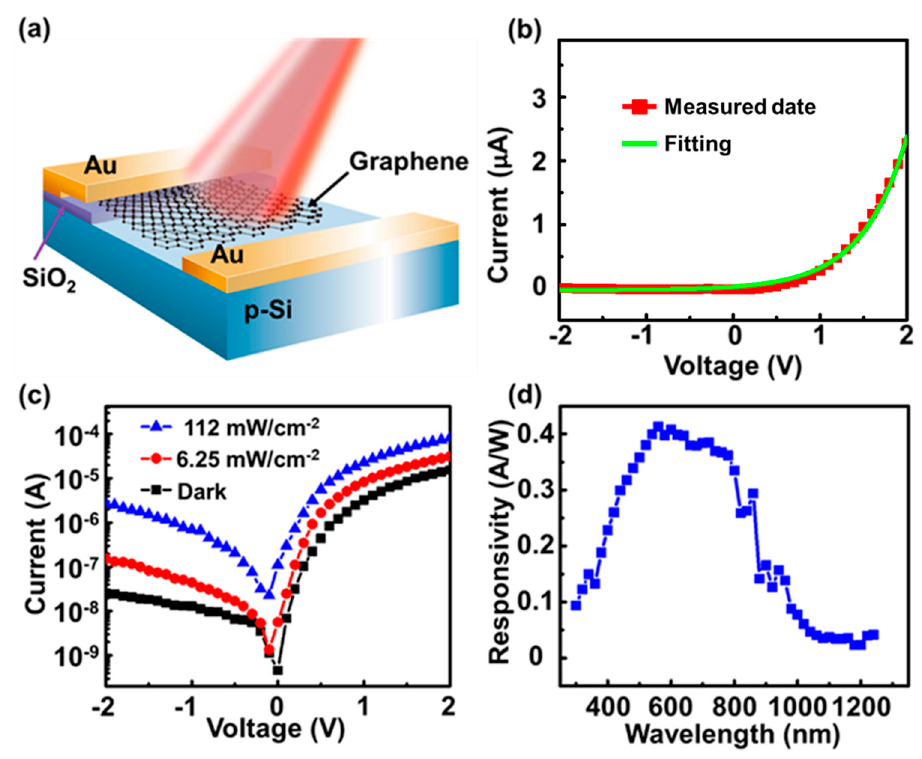
Figure 4. ( a ) Schematic of the camphor-based CVD bilayer graphene / p-Si Schottky PD; ( b ) I-V and fitting curves of the camphor-based CVD bilayer graphene / p-Si Schottky PDs in the dark; ( c ) I-V curves of the camphor-based CVD bilayer graphene / p-Si Schottky PDs in the dark and under white light illumination with 6.25 and 112 mW / cm − 2 , respectively. ( d ) Spectral responsivity of the camphor-based CVD bilayer graphene / p-Si Schottky PDs under zero bias.